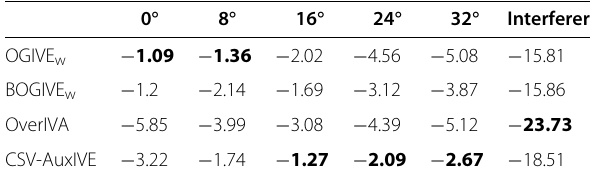
Table 2 The attenuation (dB) in selected points on the source path and in the position of the